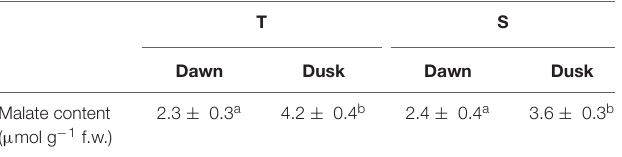
TABLE 3 | Diurnal change in malate contents in terrestrial and submerged leaves of H. polysperma . T S Dawn Dusk Dawn Dusk Malate content ( µ mol g − 1